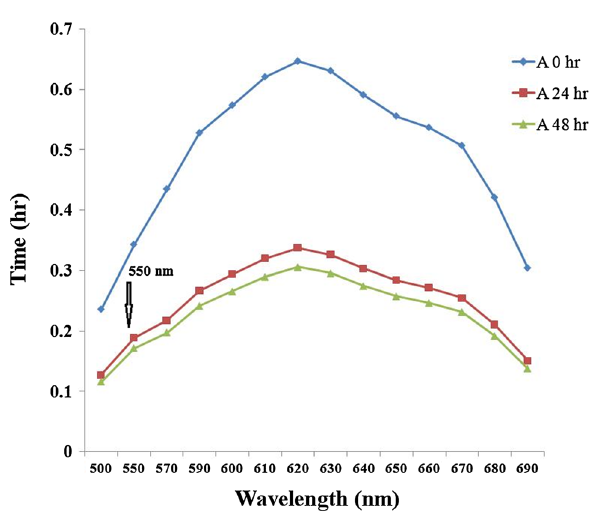
Fig. 7 Spectral analysis of MB after 0, 24 and 48 h with Stenotrophomonas maltophilia